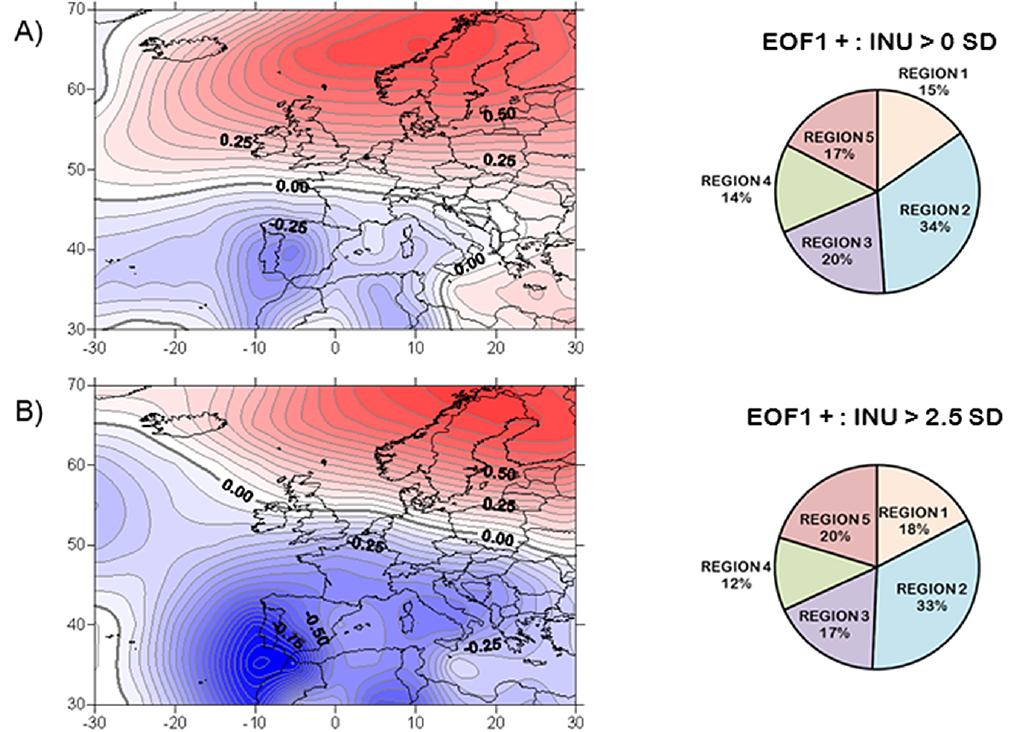
Figure 11. (a) Left: composites of monthly EMSLP extracted from 20CRP plus the Luterbacher reanalysis grids of the years with EOF1 in the positive phase and INU >0. The units are expressed in hPa. Red (blue) contours show positive (negative) anomalies. Right: number of floods in percentage by region. (b) is as (a) but for the years with INU >2.5SD. Region 1 encompasses Valais and western cantons, region 2 the western part of the northern slope of the Alps and the Swiss Plateau, region 3: Grisons plus the southern flank of the Alps, region 4 eastern Jura and the Swiss Plateau and region 5 encompasses the eastern part of the northern flank of the